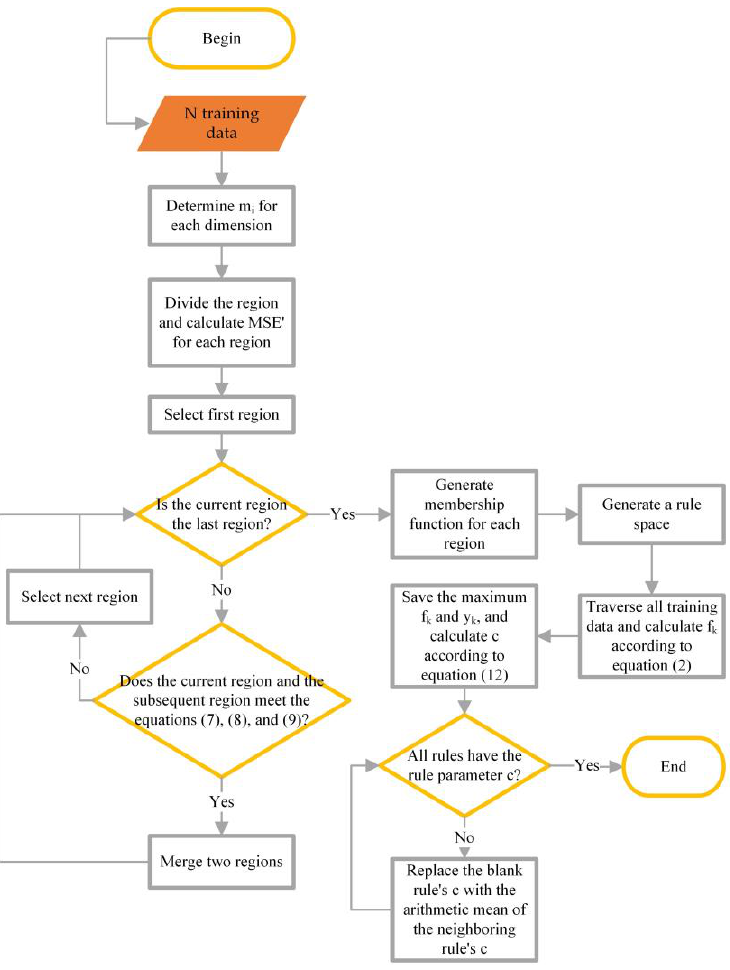
Figure 3. The flowchart of the Modified Wang–Mendel Method.